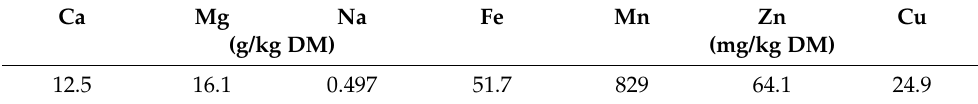
Table 2. Analysed mineral content of the clay mineral mixture after digestion with nitric